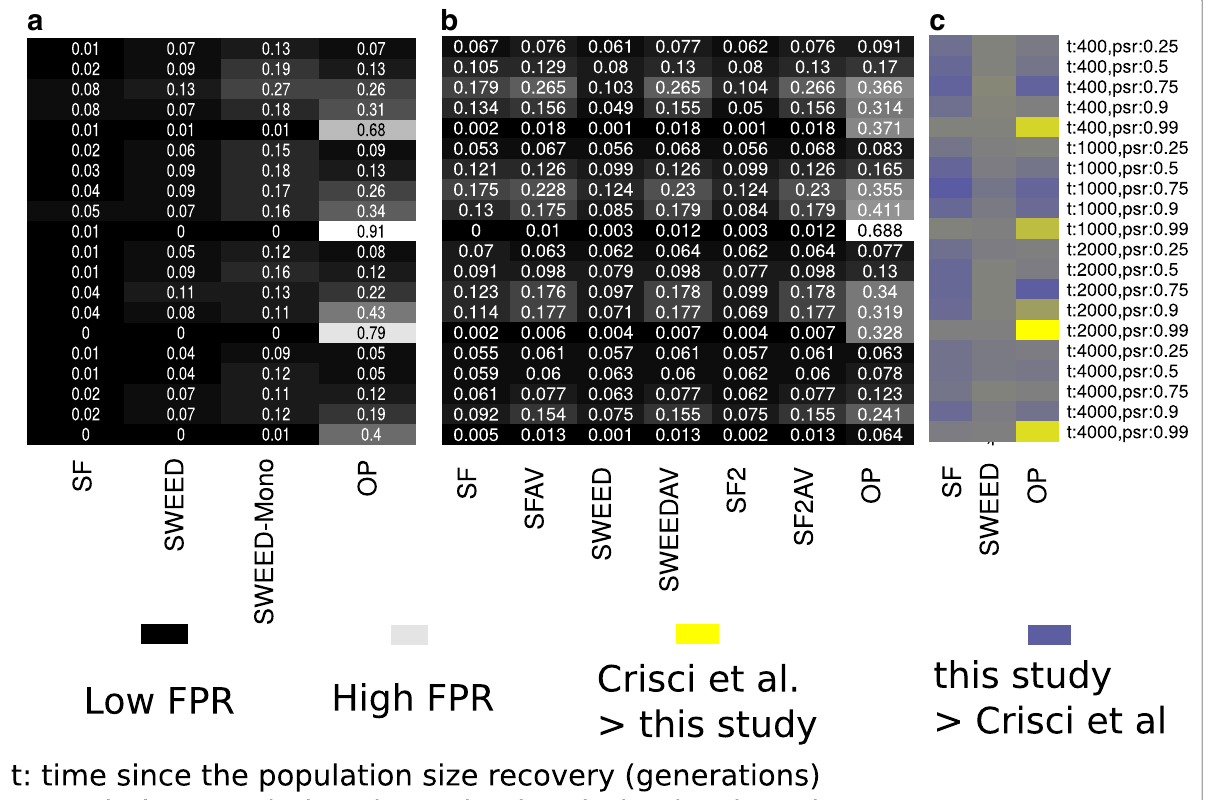
Fig. 4 False positive rates for the selective sweep detection process under various algorithms and demographic models. Demographic models consist of bottlenecks and are characterized by two parameters: t is the time in generations since the recovery of the populations, and psr the relative population size reduction during bottleneck. Prior to the bottleneck, the population size equals to the present-day population size. We show the results from the study of Crisci et al. [15] ( a ), our analysis in the current study ( b ) and the difference between a and b ( c ). Note that Crisci et al. studied SweepFinder (SF), SweeD (SWEED), SweeD with monomorphic (SWEED-Mono) and OmegaPlus (OP). In the current work, we studied SweepFinder (SF), SweepFinder with average SFS (SWEEDAV), SweeD (SWEED), SweeD with average SFS (SWEEDAV), SweepFinder2 (SF2), Sweep- Finder2 with average SFS (SF2AV), and OmegaPlus. Thus, in c we show only results from the common tools (SF, SWEED, OP). In a and b , the darker a cell, the lower the false positive rate. In c , yellow denotes that Crisci et al. report higher false positive rate than this study, while blue denotes that the reported false positive rate by Crisci et al. is